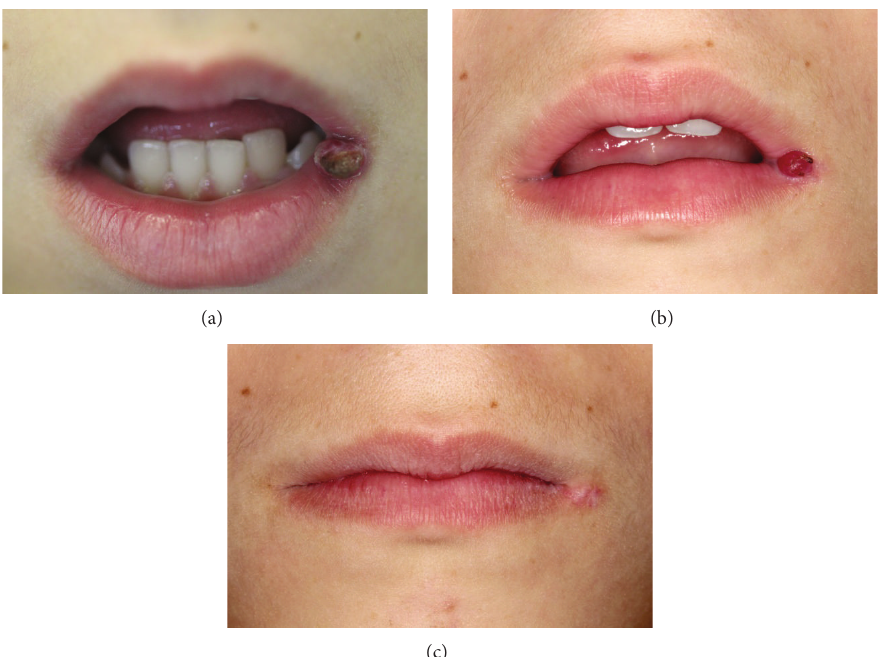
Figure 1: Clinical presentation of case 1. (a) Initial presentation shows a red to purple nodule with a sessile base, measuring approximately 1cm in diameter. (b) Recurrence of the lesion in the same anatomic site. (c) One-year follow-up clinical